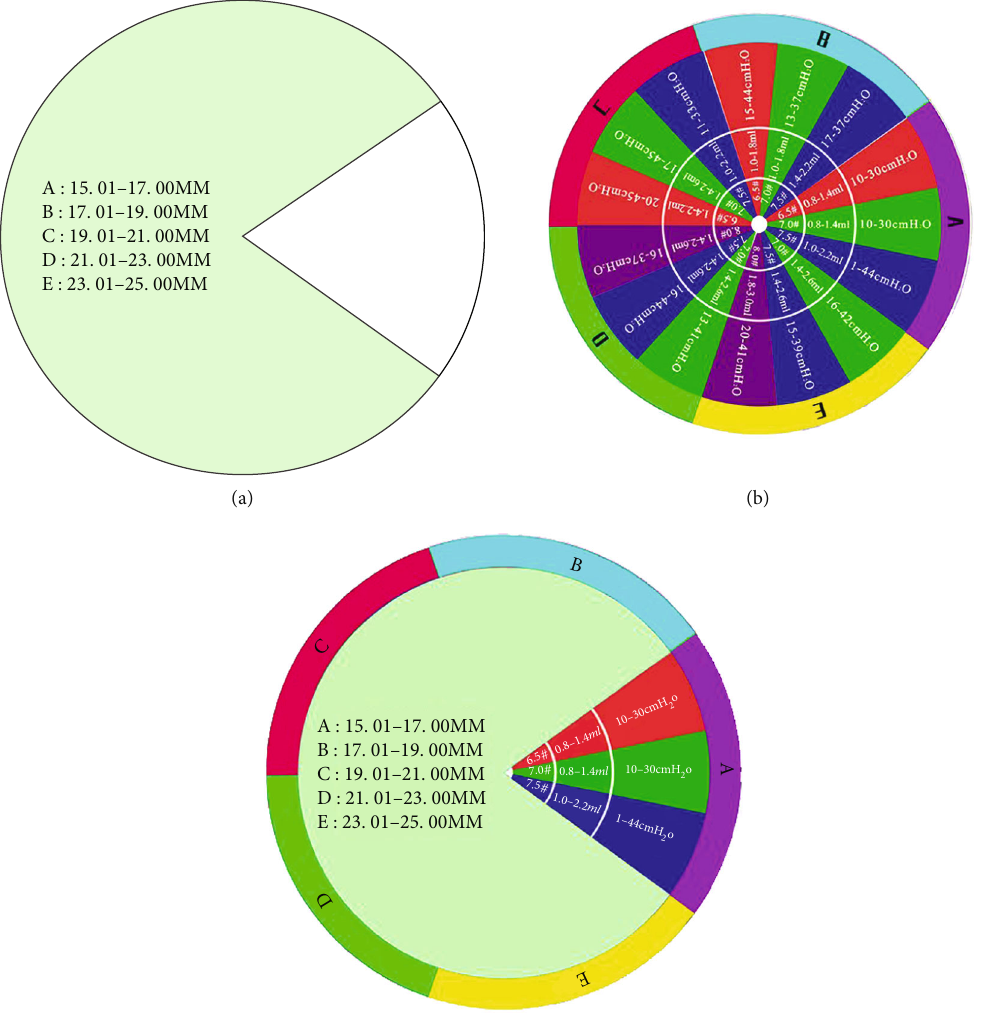
Figure 4: (a) The fi rst page — trachea diameter grouping. (b) The second page — recommended best air injection volume and the pressure range to be achieved. (c) The fi nal form is combined (a) and (b).